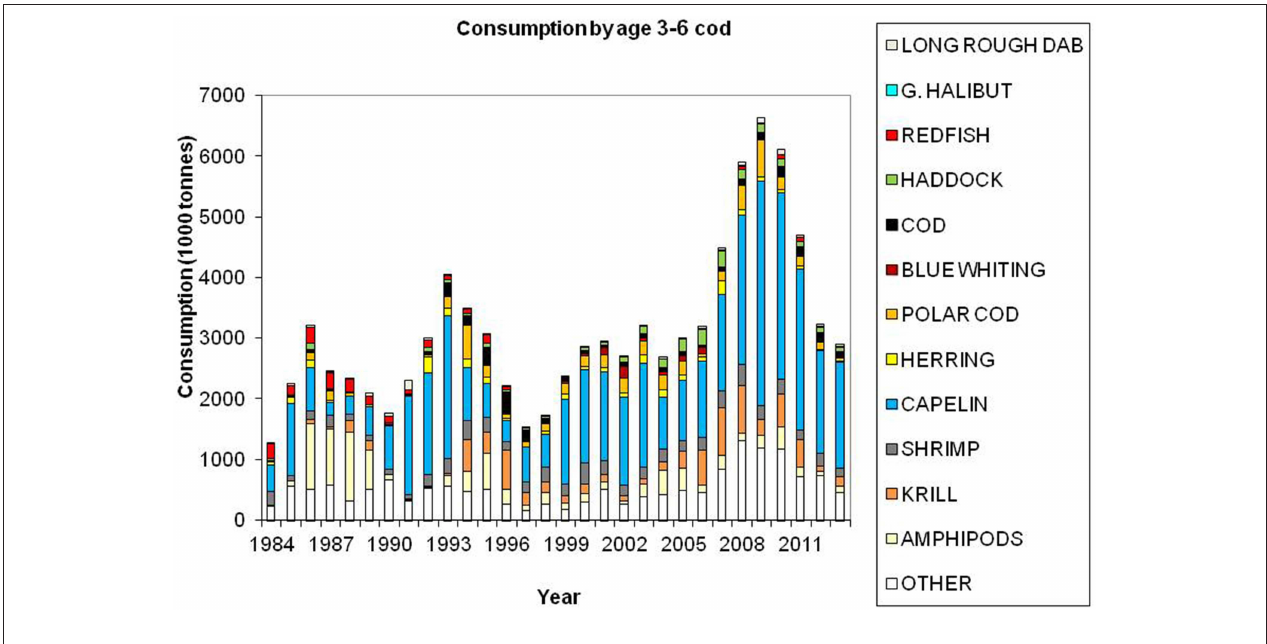
FIGURE 8 | Total consumption by age 3–6 cod based on calculations presented in ICES (2014a), using the method described by Bogstad and Mehl (1997). These calculations are